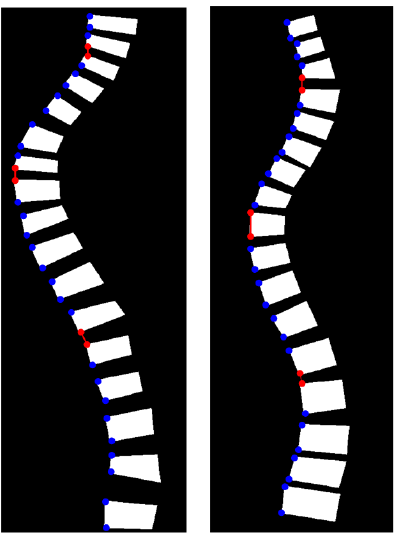
Figure 8. Examples for key segments in the segmented spinal image.